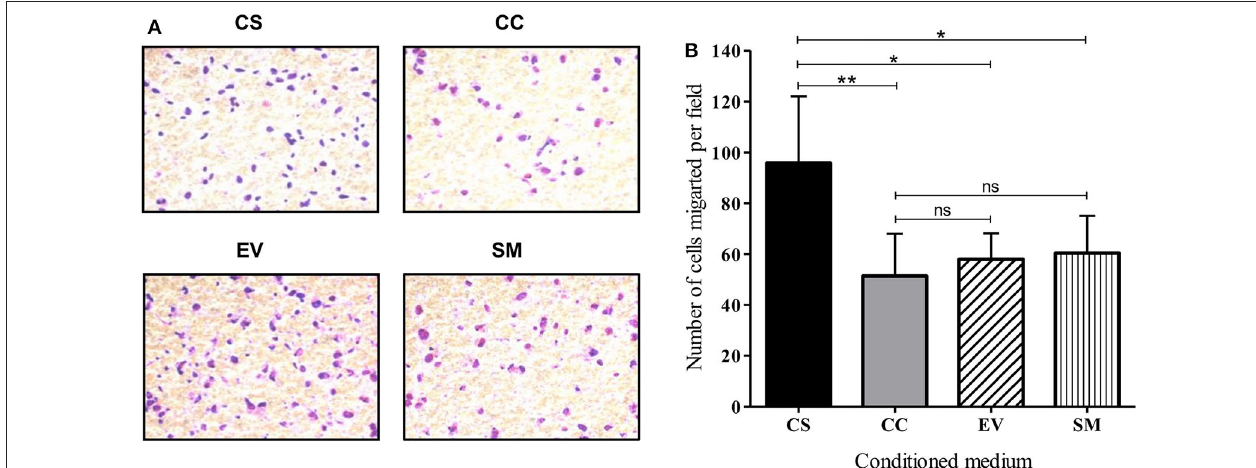
FIGURE 5 | CS-Tat stimulates superior migration and invasion of HUVEC following an exposure to Jurkat-Tat-conditioned media. (A) HUVECs suspended in serum-free media were seeded in Matrigel (300 µ g/ml) coated 8 µ m cell culture inserts at a density of 0.5 × 10 6 cell/ml. The receiver wells contained conditioned media as labeled. HUVEC seeded in RPMI supplemented with 10% FBS served as the background (SM) control. The cells that did not migrate were scraped off using cotton swabs. The cells that migrated toward the lower chamber after 12h of incubation were fixed, permeabilized, and stained with Giemsa for imaging using a 20 × objective. (B) Five fields per treatment were imaged and the number of migrated cells were counted using ImageJ. The mean numbers of cells per field ± SD were plotted for each treatment. Conditioned media from Jurkat cells were harvested at 12h post-dox induction. The data are representative of three independent experiments. One-way ANOVA with Tukey–Kramer post-test (* p < 0.05, ** p < 0.01 and ns,